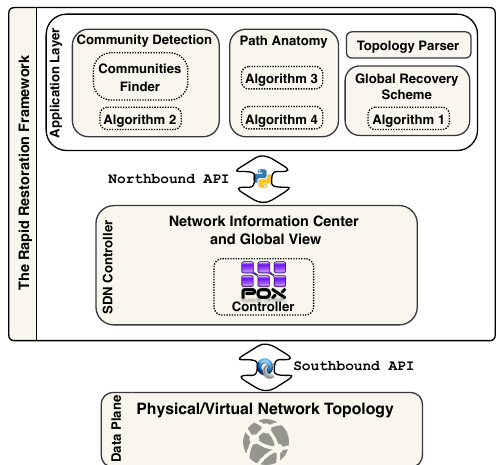
Figure 4. Proposed framework components: the primary contribution of this paper lies in the Community Detection and the Path Anatomy blocks. Openflow is used on the southbound interface and POX python APIs are used on the northbound interface. The framework components are labelled with the algorithms that describe their